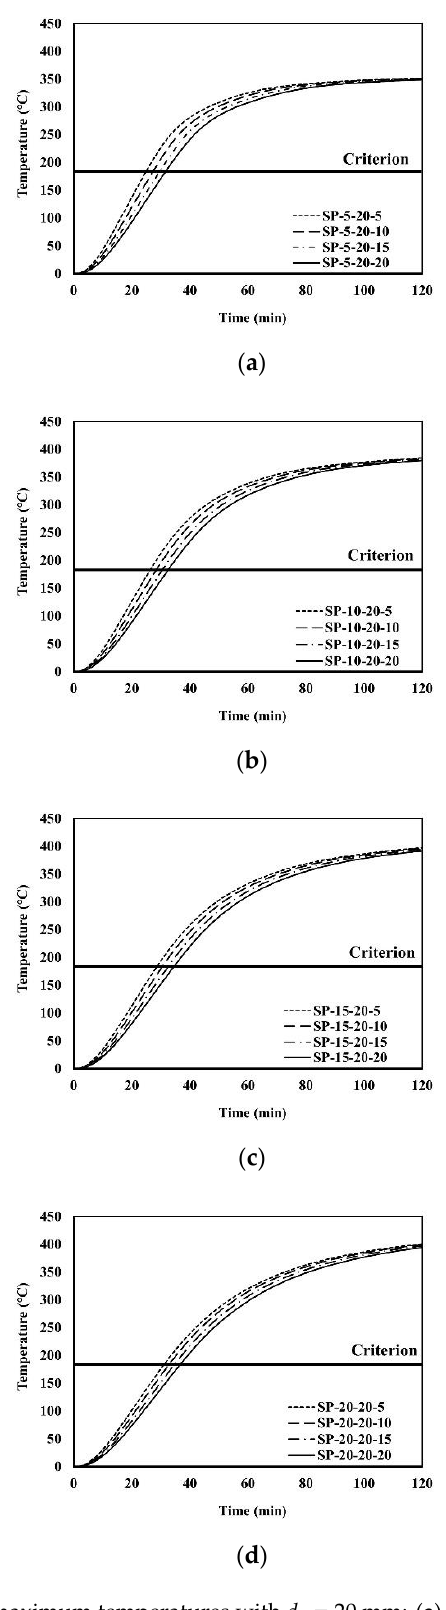
Figure 13. Time history of maximum temperatures with d p = 20 mm: ( a ) SP-5-20-x; ( b ) SP-10-20-x; ( c ) SP-15-20-x; ( d ) SP-20- 20-x.